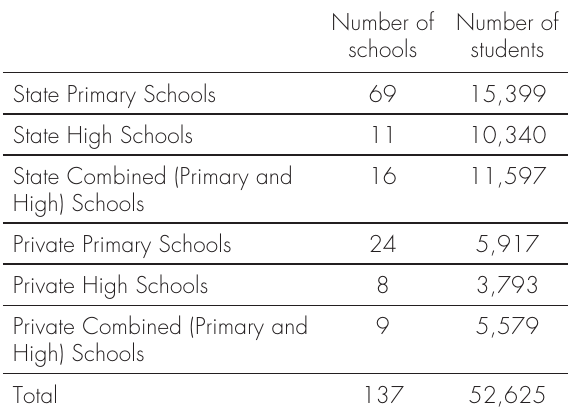
Table I. All the schools in the Cairns region of Far North Queensland that were contacted for participation.